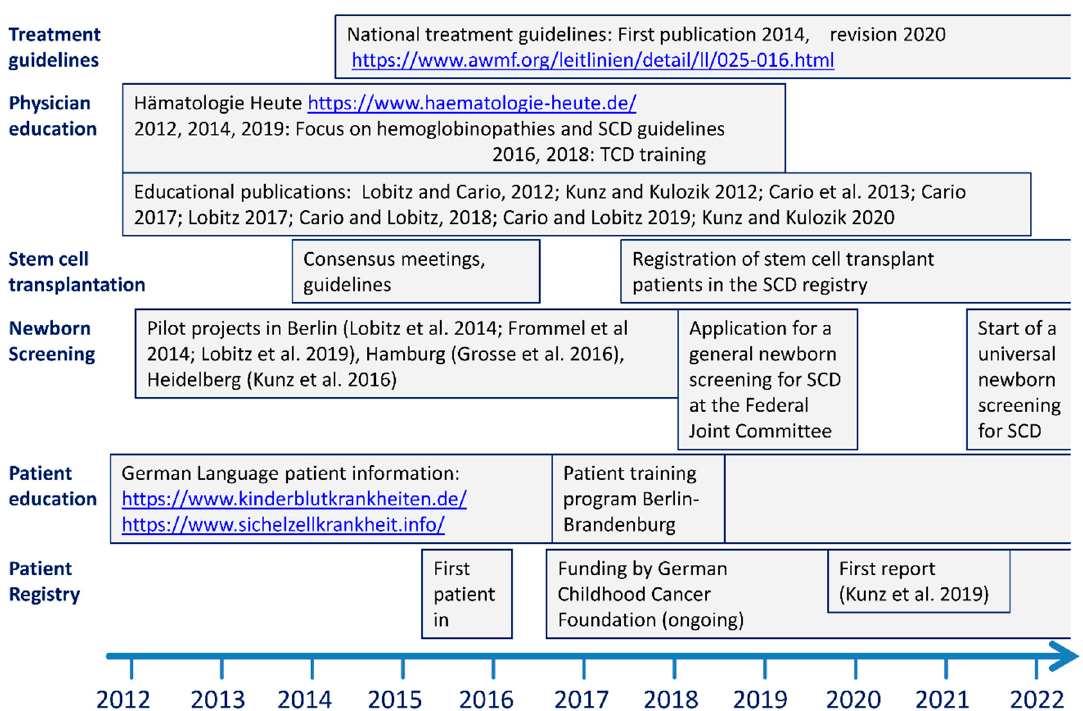
Figure 1. Disease management activities by the German SCD consortium. Physician education primarily included national guidelines [12] on the treatment of SCD that were disseminated by annual meetings and by publications in German language (see Supplementary References). Stem cell transplant physicians were enrolled in the consensus finding for the treatment guideline. Several pilot projects [6–10] prepared for a general new-born screening and led to a formal application at the Federal Joint Committee, the political body that recently decided the implementation of such a screening for 10/2021. Patient education was provided online and with the help of a structured training program at the Kindernachsorgeklinik Berlin Brandenburg, an institution specialized in rehabilitation of chronically ill children that closed by the end of 2019. Results of the national patient registry were reported elsewhere [5]. All websites that are mentioned in the Figure were accessed on 9 July